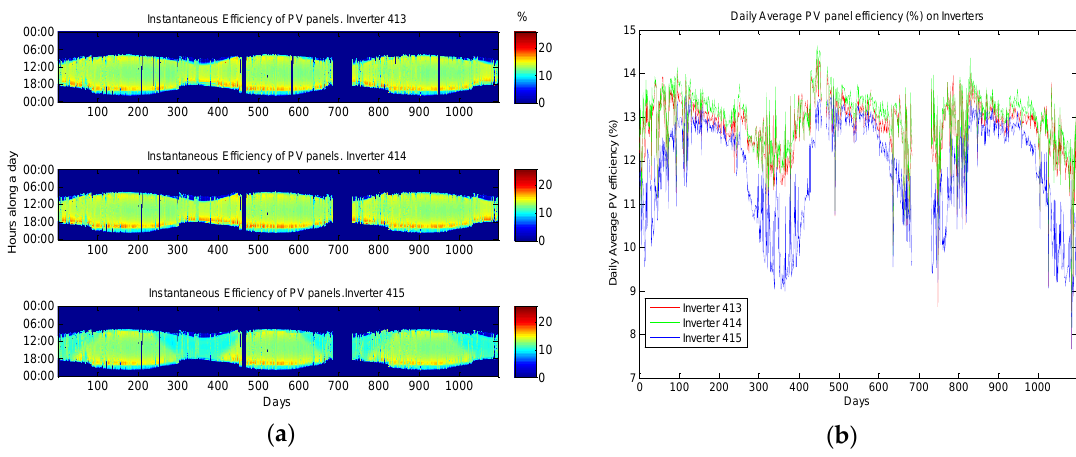
Figure 11. PV panels’ efficiency from 1 January 2011 to 31 December 2013: ( a ) instantaneous values, during 24 h a day; and ( b ) total daily values.